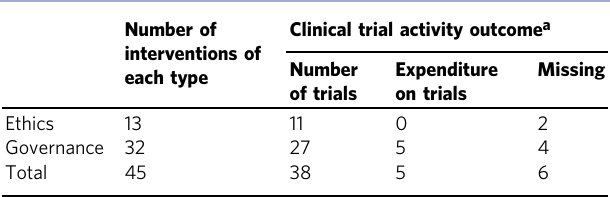
Table 1 Intervention types and forms of outcome